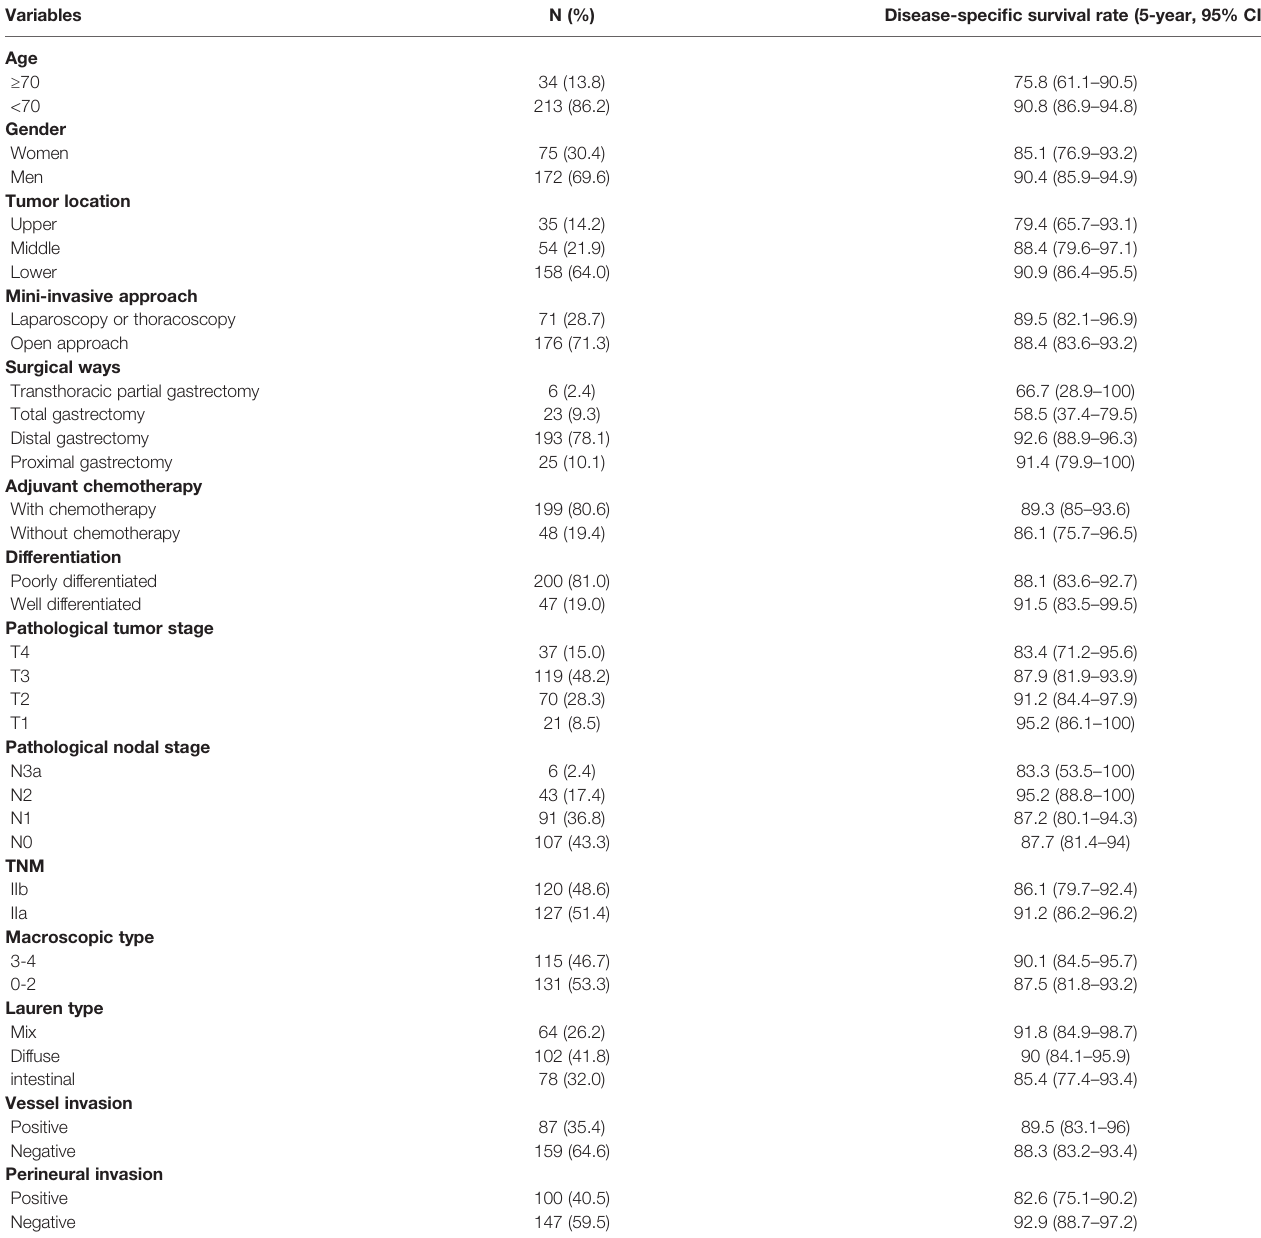
TABLE 1 | Demographic and clinical characteristics of the patients at